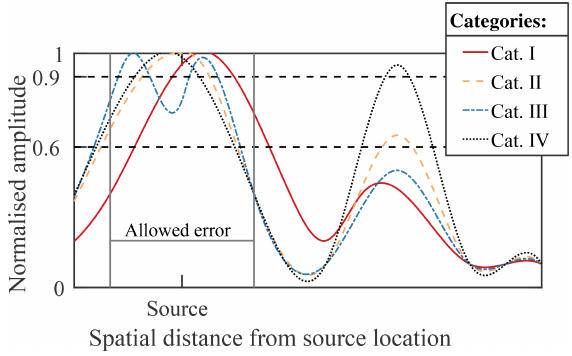
Figure 2. One-dimensional schematic outlining the four different categories that were used to rank simulation set-ups by their loca- tion